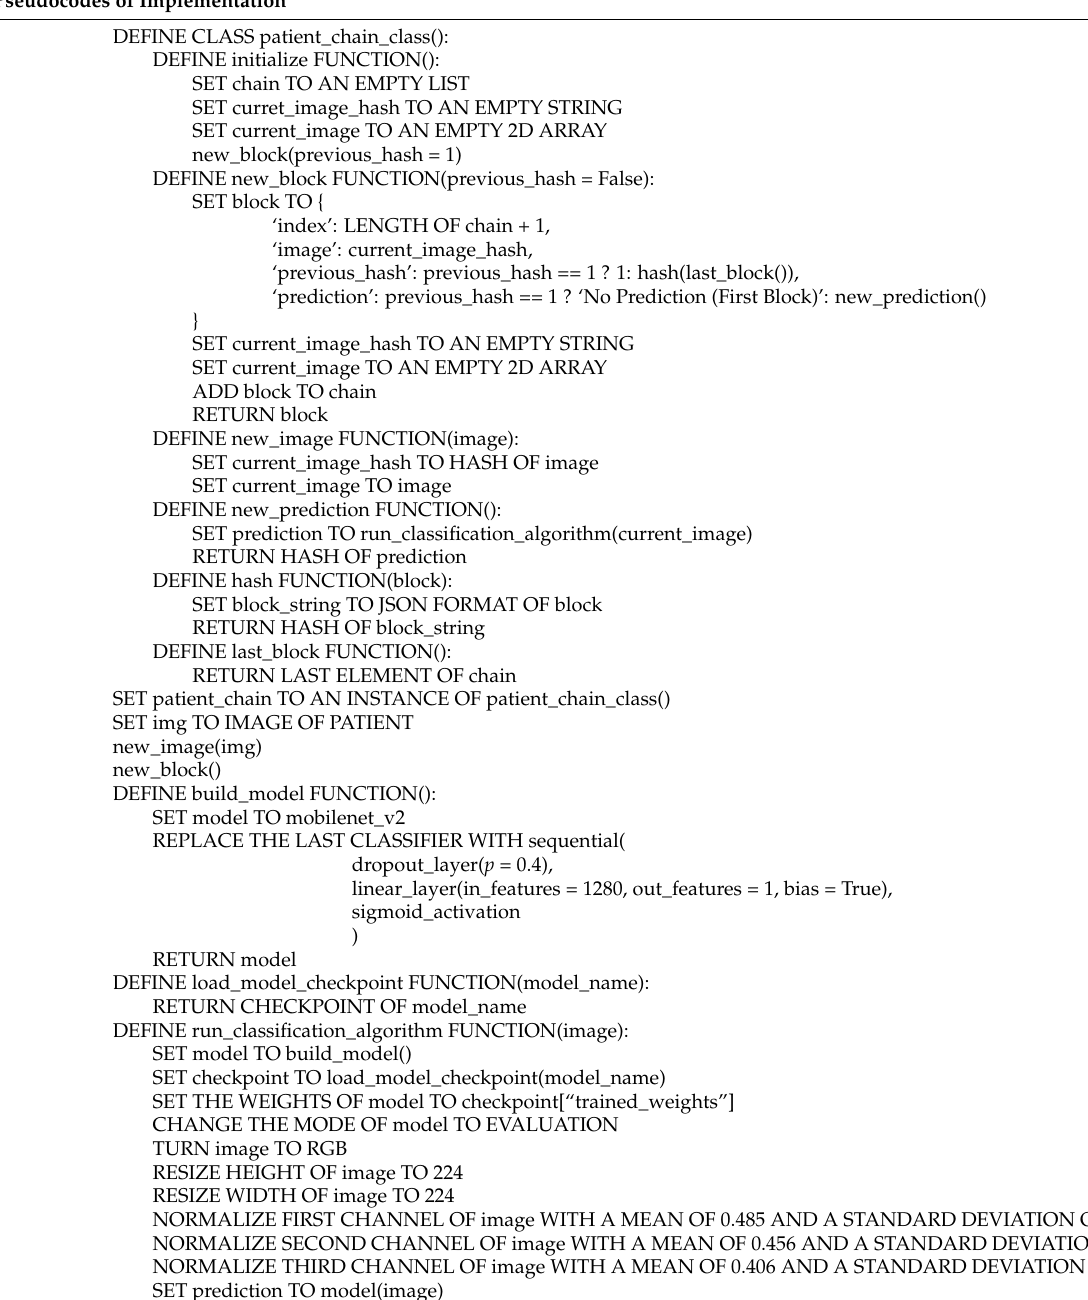
Table 3. Pseudocode of implementation of the platform within